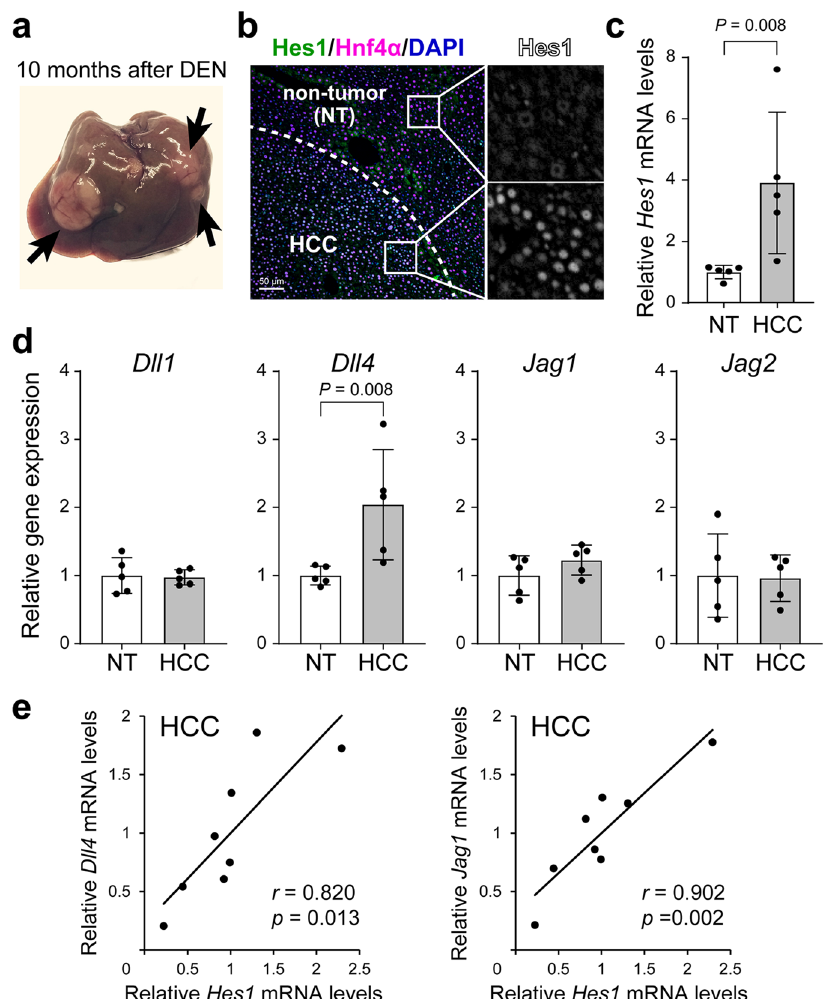
Fig. 1 Expression levels of the Notch signal-related genes in diethylnitrosamine (DEN)-induced murine hepatocellular carcinoma (HCC). a A macroscopic picture of liver tumors developed 10 months after the administration of DEN. Arrows indicate the tumors observed on the liver surface. b DEN-induced HCC tissues were analyzed by immuno fl uorescent double-staining with anti-Hes1 ( green ) and anti-Hnf4 α ( magenta ) antibodies together with 4 ′ ,6-diamidino-2-phenylindole (DAPI) nuclear staining ( blue ). Scale bar, 50 μ m. c , d Total RNA isolated from the non-tumorous region ( NT ) and HCC was subjected to quantitative reverse-transcription (RT)-PCR analysis to detect the expression levels of Hes1 ( c ), Delta-like 1 ( Dll1 ), Delta-like 4 (Dll4) , Jagged-1 ( Jag1 ), and Jagged-2 ( Jag2 ) ( d ). The values represent the mean ± standard deviation (SD) from fi ve samples and are expressed relative to the mean value in NT (set as 1.0). e Correlations between the amounts of Hes1 mRNAs and Dll4 or Jag1 mRNAs were analyzed using DEN-induced HCC samples obtained from eight male